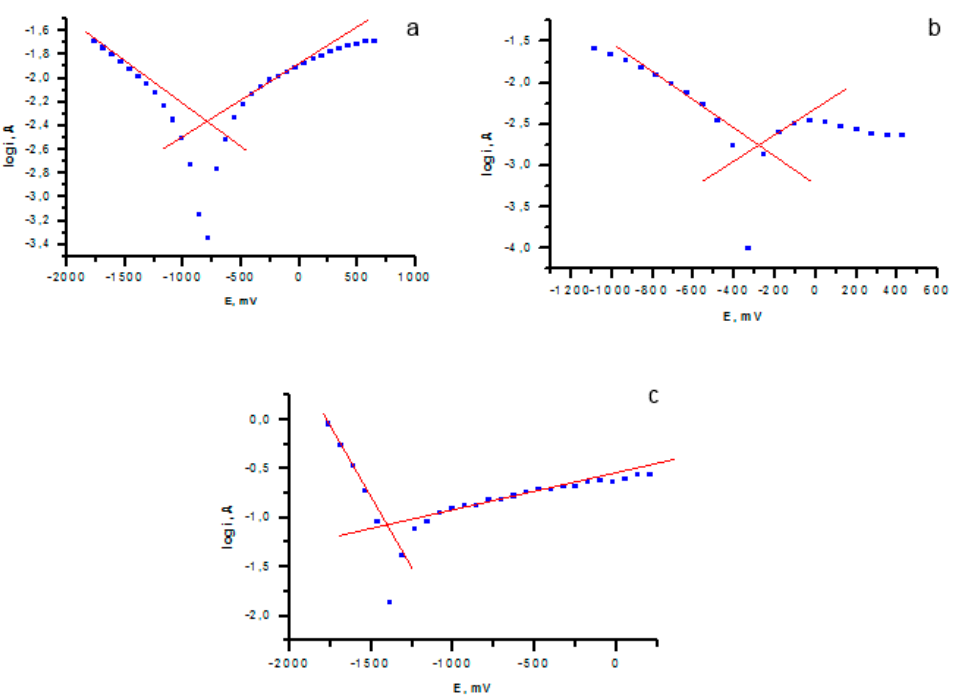
Figure 10. Corrosion properties of samples: ( a ) 15CrMoV5-9 alloy without coating, ( b ) 15CrMoV5-9 + V 2 O 5 , and ( c ) 15CrMoV5-9 + V 2 O 5 /C.